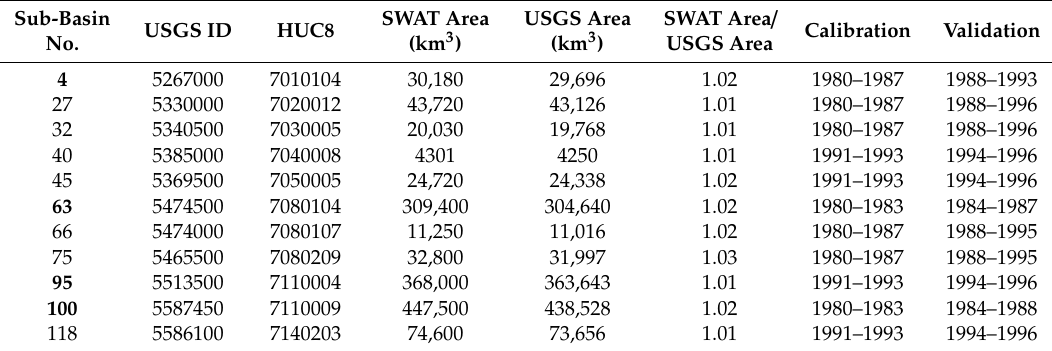
Figure 3. Location of USGS monitoring stations and sub-basins simulated by the Soil and Water Assessment Tool (SWAT). USGS stations 5267000, 5474500, 5513500, and 5587450 are located on the mean stream (see Table 1 for their corresponding sub-basin outlets). Table 1. The drainage area of each monitoring station, the corresponding SWAT simulated drainage area, and the time period of observation data used in this